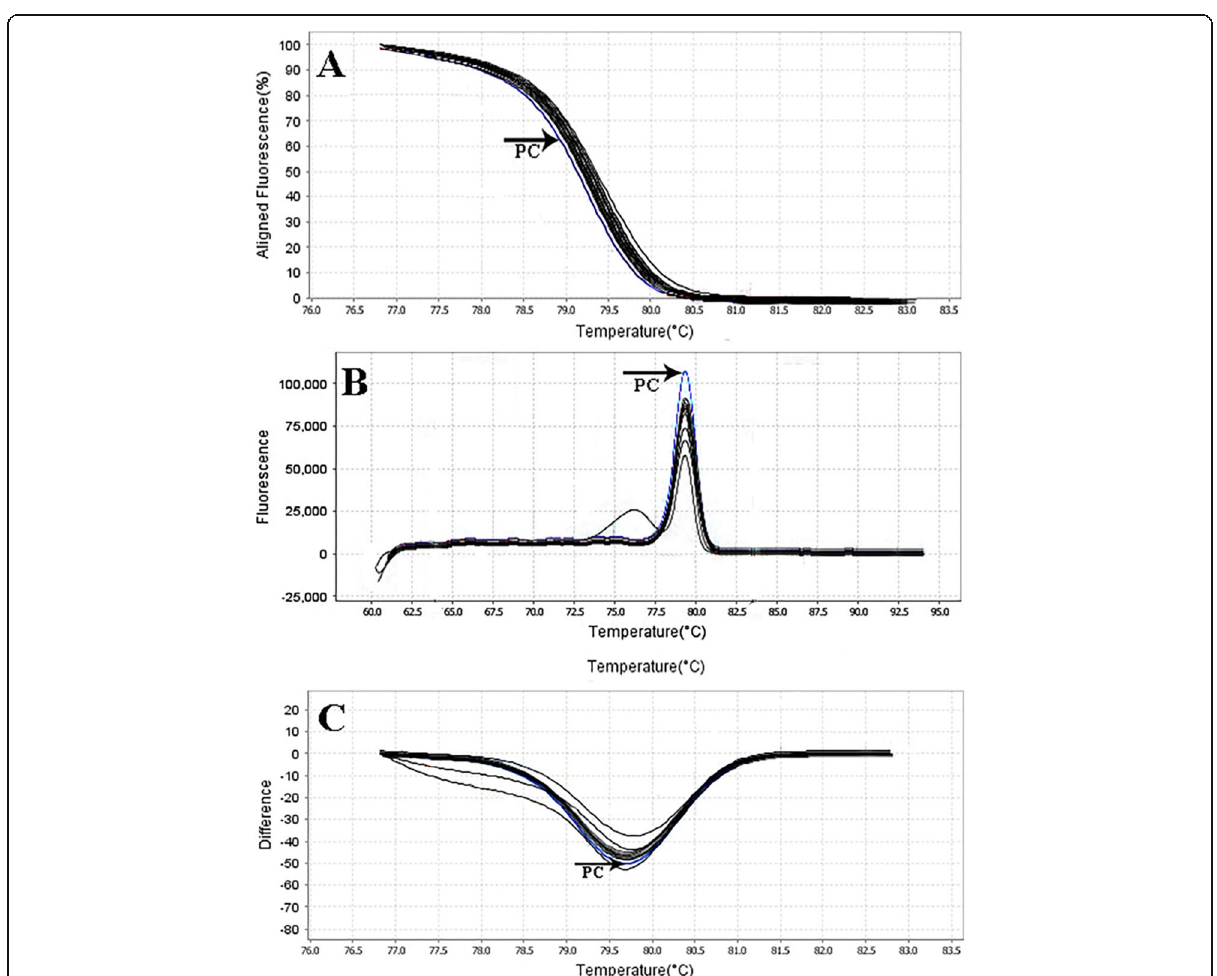
Fig. 6 HRMA graphs corresponding to one high-resolution melting analysis of a subset of clinical specimens ( n = 18). Curves of tested samples previously identified as E. faecalis are shown in black lanes. DNA samples in this study were prepared and amplified successfully using the EvaGreen dye-based method in the ABI instrument. Primer-specific melting peaks (Tm) were obtained via HRM analysis, allowing the differentiation of all investigated β -lactamase enzymes. Due to the highly saturating EvaGreen dye and the HRMA analysis, the accuracy of the resolution was ± 0. 1 – 0.5